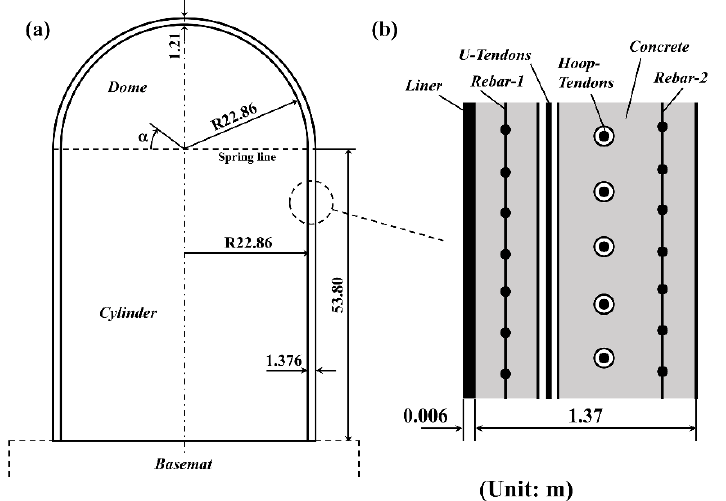
Figure 9. ( a ) The geometry of reactor containment building of APR1400 [1] ( b ) Schemeatic of the RCB wall. (Single-column fit).